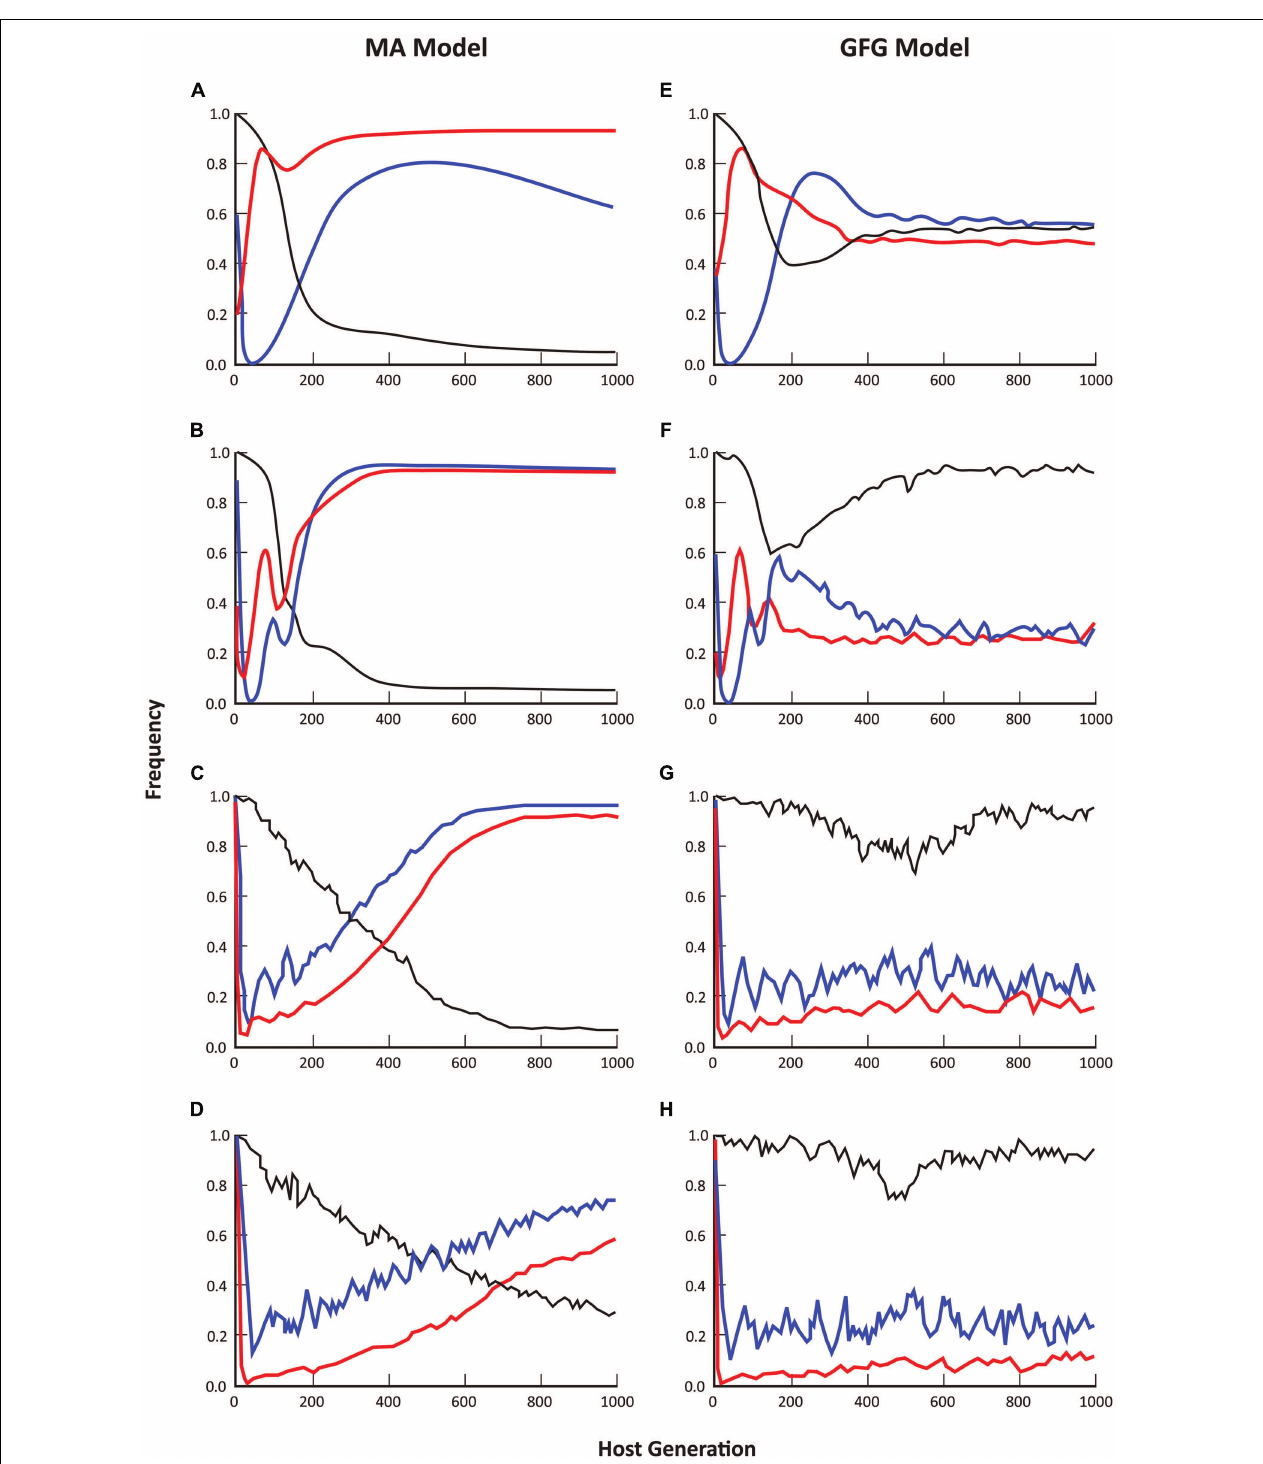
FIGURE 1 | Comparison of epidemiological patterns predicted by the matching allele and gene-for-gene models, where blue lines = disease incidence (% populations diseased), black lines = mean prevalence (% individuals infected in diseased populations), and red lines = % occupancy (fraction of sites with hosts present). Each graph represents the mean of 20 simulation runs, where runs were randomly initiated with a subset of sites being occupied by hosts and pathogens. Moving from the top pair to the bottom pair of graphs, the maximum pathogen dispersal distance was set at 1 (A, E) , 2 (B, F) , 5 (C, G) and 10 (D, H) population units respectively. Host dispersal was fixed at 5 units. In all cases, simulations were initiated with a completely susceptible host and a non-infective (i.e., only infective on the susceptible host) pathogen and allowed to evolve over 1000 generations.